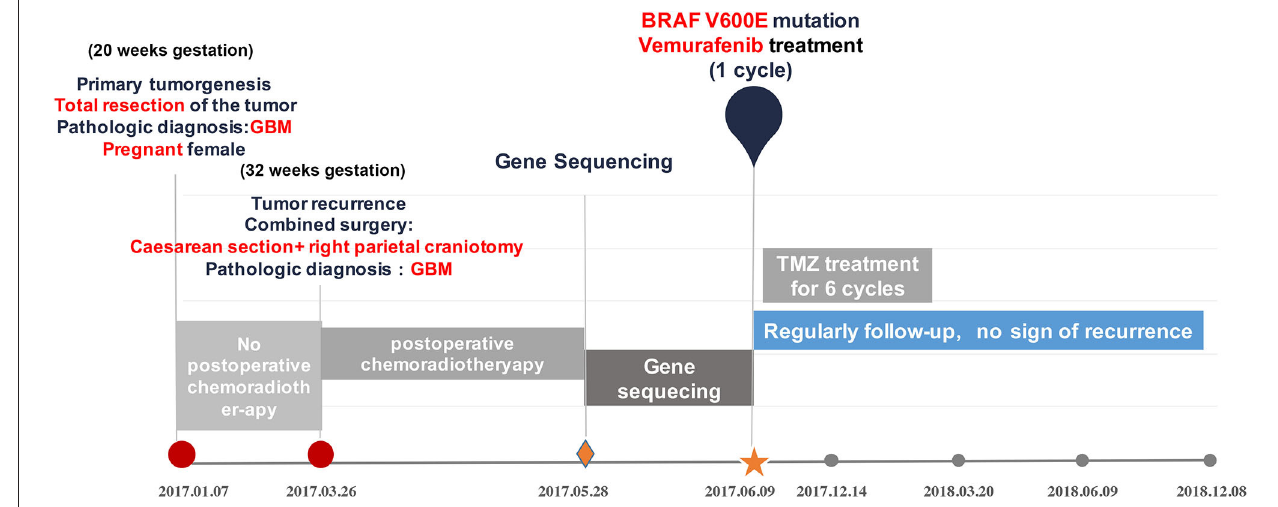
FIGURE 2 | Overview of the patient’s course of disease, treatment regimen and genetic